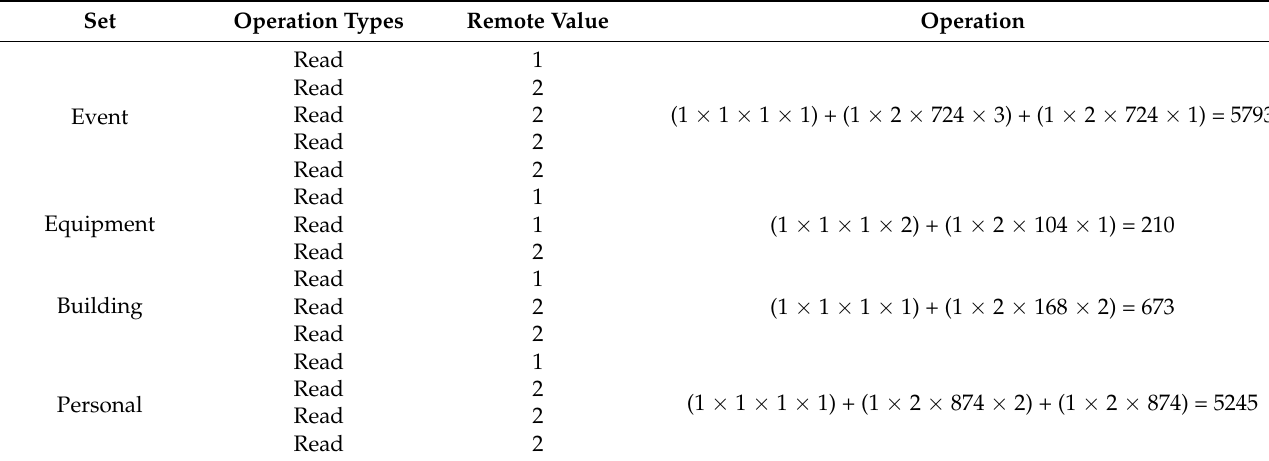
Table 5. Description of the performance value for each proposed fragment of Figure 9.